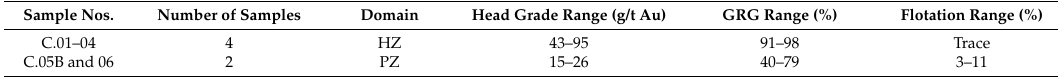
Table 16. Summary of original evaluation testwork results.